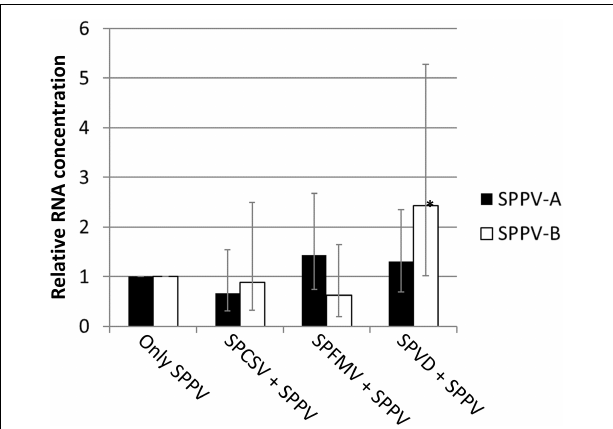
FIGURE 4 | Relative expression for Badnavirus SPPV A and B. Bar graph depicting the expression of SPPV-A and SPPV-B in leaves in coinfection with SPFMV, SPCSV, or both viruses (SPVD) relative to plants infected only with SPPV (only SPPV). Error bars indicate standard error of relative expression. *Significantly upregulated as compared to plants infected only by SPPV (only SPPV; p =